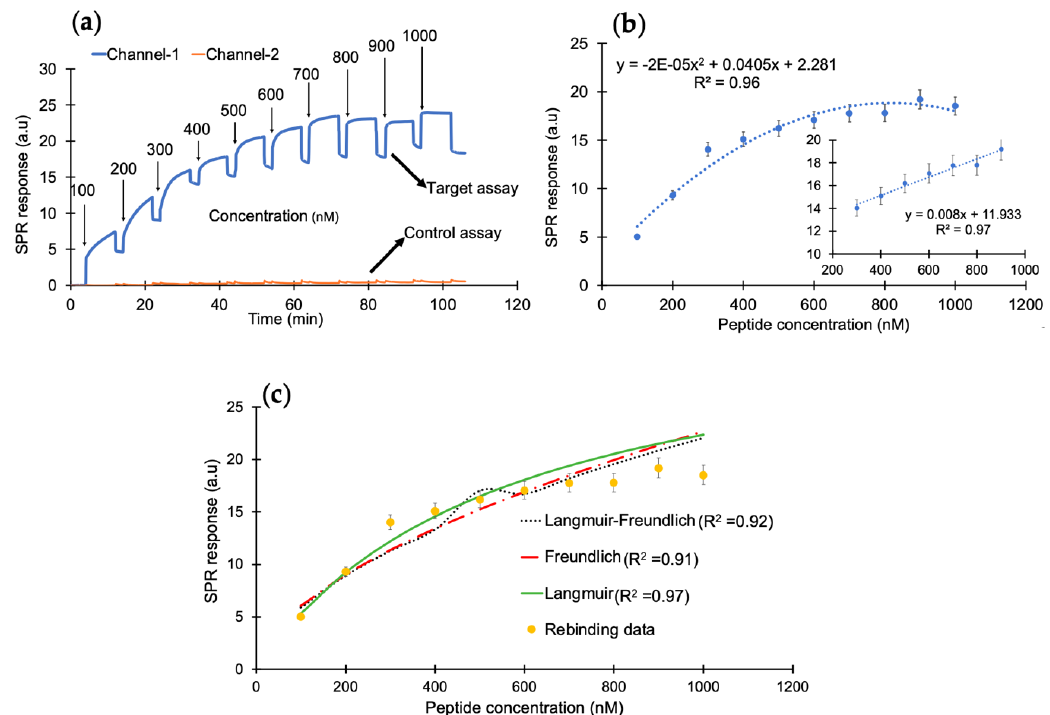
Figure 3. ( a ) The SPR sensorgram of peptide rebinding within a concentration range of 100–1000 nM. ( b ) The concentration-dependent peptide binding with a correlation coefficient of R 2 (0.97) for the linear range of 300–900 ng mL − 1 . ( c ) The binding-isotherm of peptide rebinding for a concentration range of 100–1000 nM.